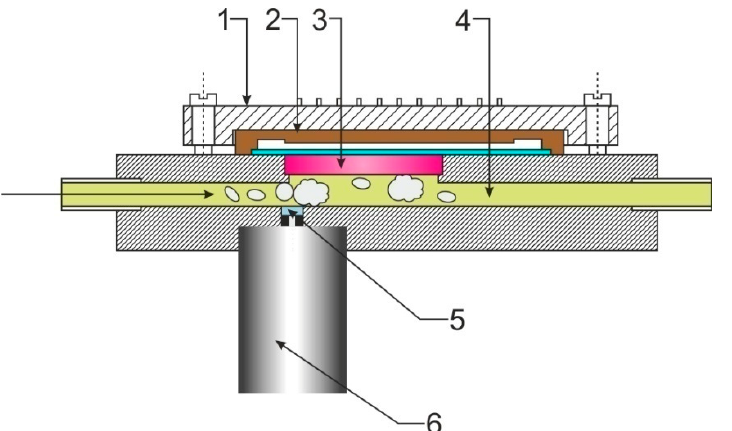
Figure 4. Schematic diagram of a laser fluorescent milk flow sensor: (1) holder of CCD array photo- detector, (2) SSD array with 3648 pixels, (3) interference band-pass filter for separating fluorescent signal, (4) milk tube; (5) replaceable raster of focused laser radiation, (6) block of lasers emitting in a pulsed modulation mode at a wavelength of 405 nm for the excitation of fluorescence.